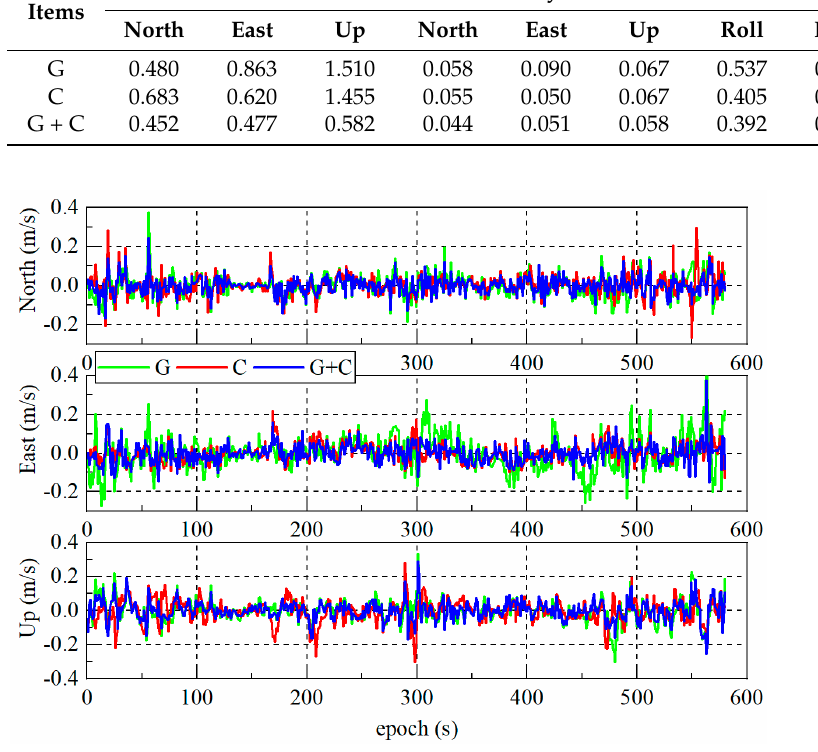
Figure 9. Velocity error of dual ‐ antenna GNSS/MIMU tightly coupled integration using the SVD ‐ RACKF in the case of single GPS (G), single BDS (C), and their combination (G + C).